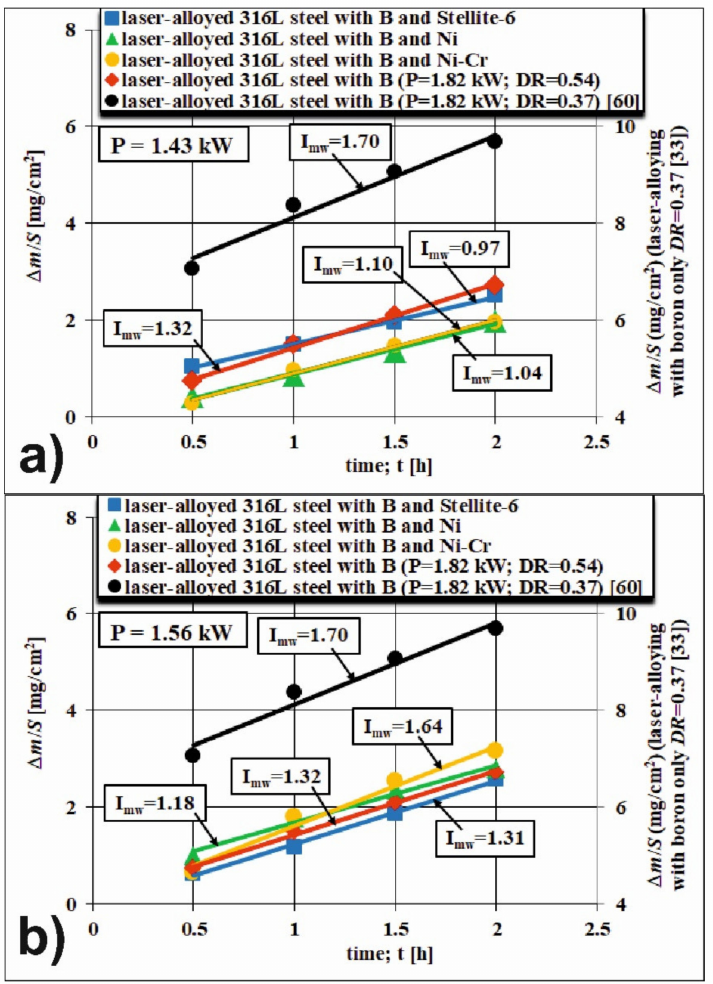
Figure 6. Results of wear tests of laser-alloyed layers with boron and selected metallic elements using the laser beam power P = 1.43 kW ( a ) and P = 1.56 kW ( b ) compared to the laser-alloyed layers with boron only at P = 1.82 kW, reported in the present study ( DR = 0.54) as well as in the paper [60] ( DR = 0.37); the mass loss per a unit of friction surface vs. time of friction after the two-hour wear test with the change of counter-specimen at every 0.5